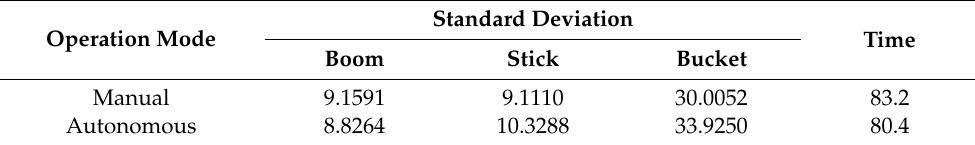
Table 3. Comparison of autonomous and manual excavation joint motion.